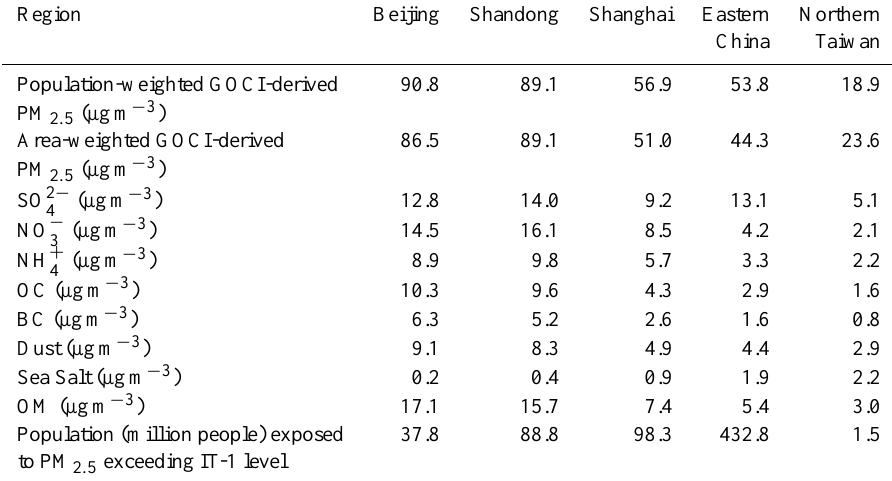
Table 1. Annual PM 2 . 5 concentrations, area-weighted concentrations of chemical composition and affected population of PM 2 . 5 in regions outlined in Fig. 3 and in overall eastern China (excluding northern Taiwan) for 2013. Aerosol water is not associated with each PM 2 . 5 component for consistency with measurement protocols. PM 2 . 5 concentration is at 35% relative humidity. IT1 refers to the WHO air quality interim target-1 of 35µgm − 3 . Region Beijing Shandong